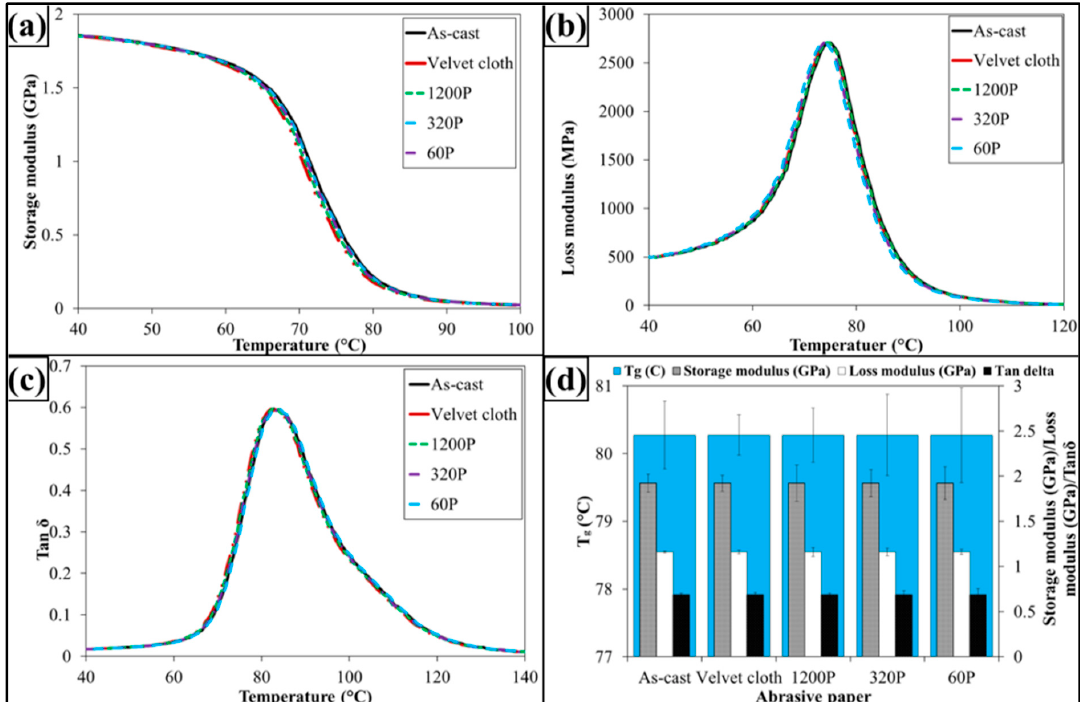
Figure 8. Dynamic mechanical properties of 0.1 wt % MLG-EP nanocomposites: ( a ) Storage modulus; ( b ) Loss modulus; ( c ) Loss factor (Tan δ ); ( d ) Glass transition temperature ( T g ), storage modulus, loss modulus and Tan δ values corresponding to T g .